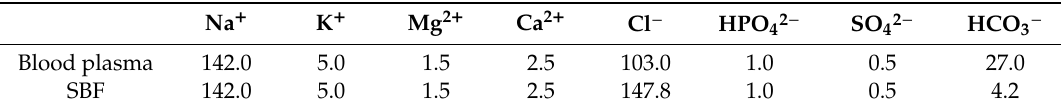
Table 1. Ion concentrations (mM) of simulated body fluid (SBF) used in this experiment and human blood plasma